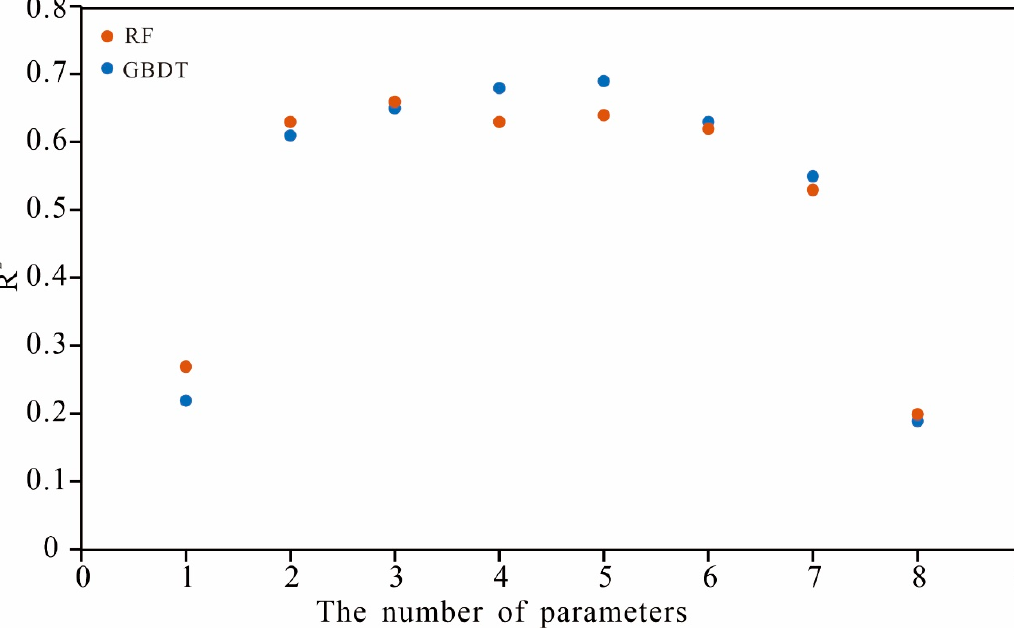
Figure 4. The relationship between RSQ and the number of parameters.